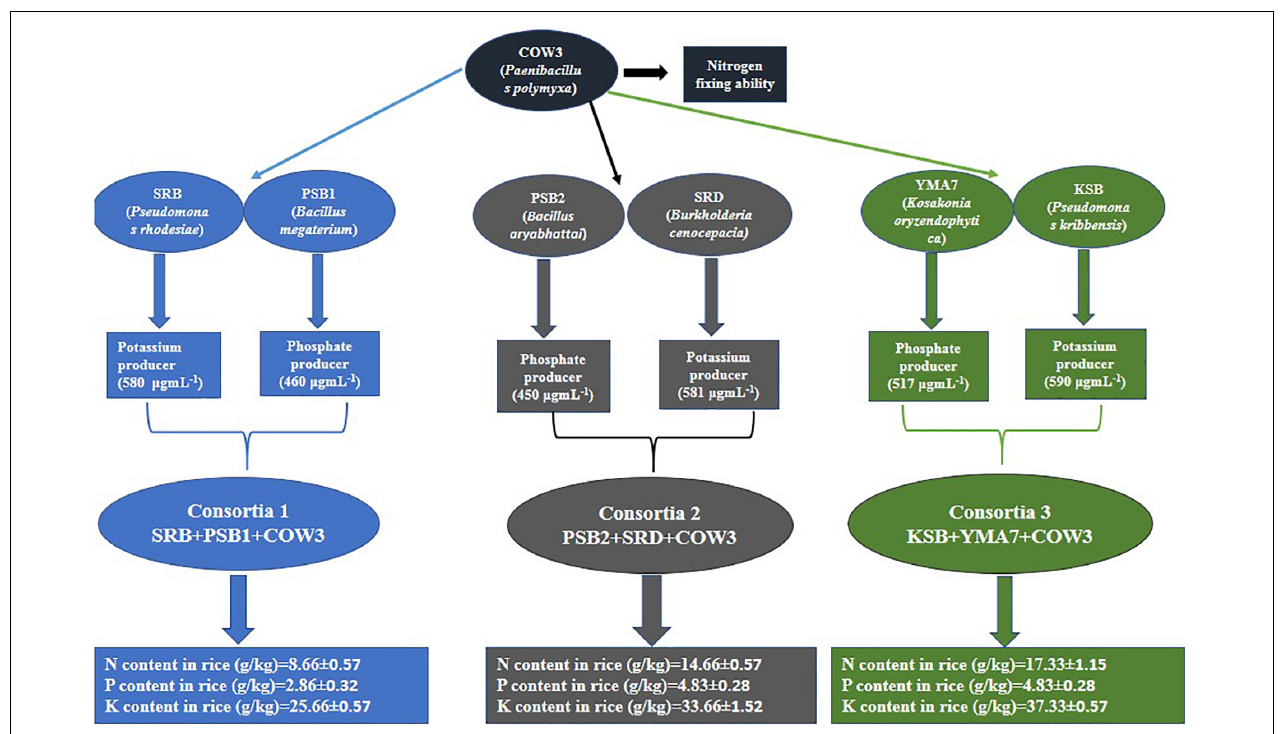
FIGURE 2 | Flowchart representation of the PGP traits as shown by the individual isolates and consortia. TABLE 3 | Effect of bacterial consortia inoculation on plant growth promotion after 60 days of transplanting of rice at farmer’s field. Microbial consortia Tiller number per